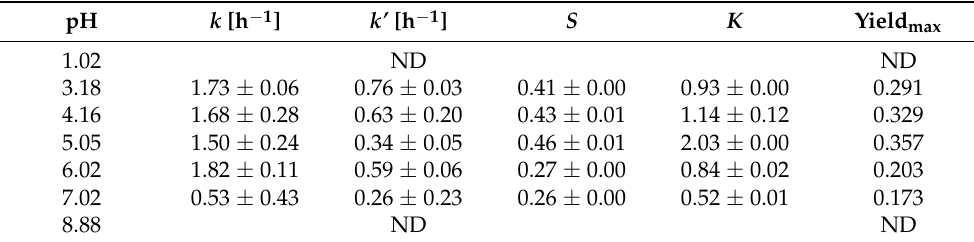
Table 3. Effect of pH on dipeptide synthesis ( w 0 = 28, DCC= 7 mol/m 3